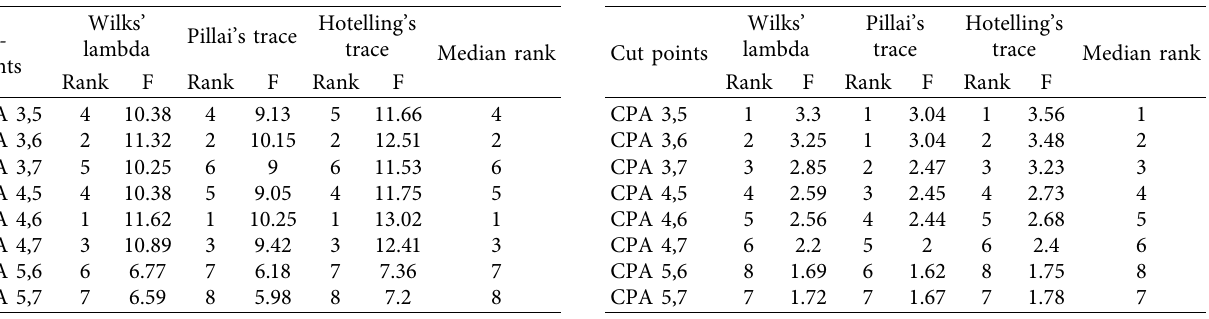
Table 5: Schizophrenia spectrum disorders. Table 2: Overall interference.